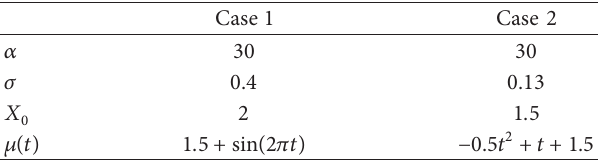
Table 1: Simulation parameters for sinusoidal and parabolic trend functions. Case 1 Case 2 𝛼 30 30 0.4 0.13 1.5 1.5 + sin (2𝜋𝑡) −0.5𝑡 2 + 𝑡 +